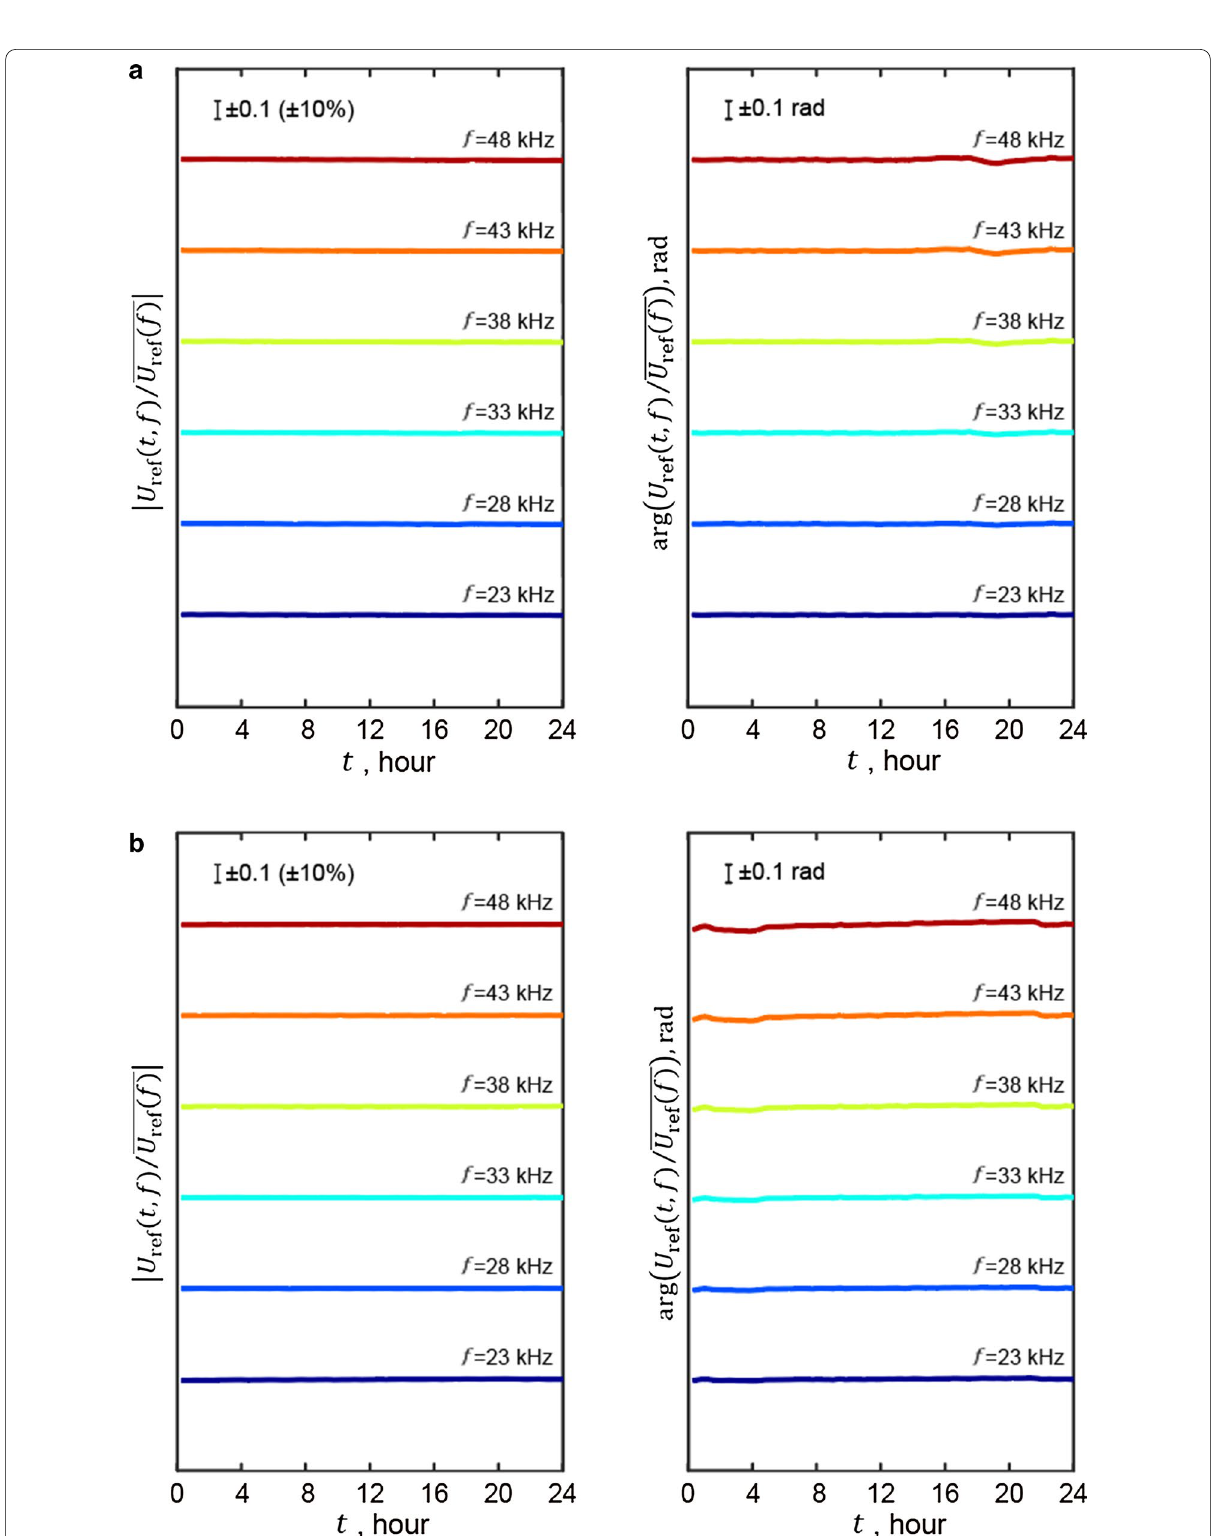
Fig. 5 Time histories of normalized amplitude and normalized phase for AC ref under a dry and b nearly saturated